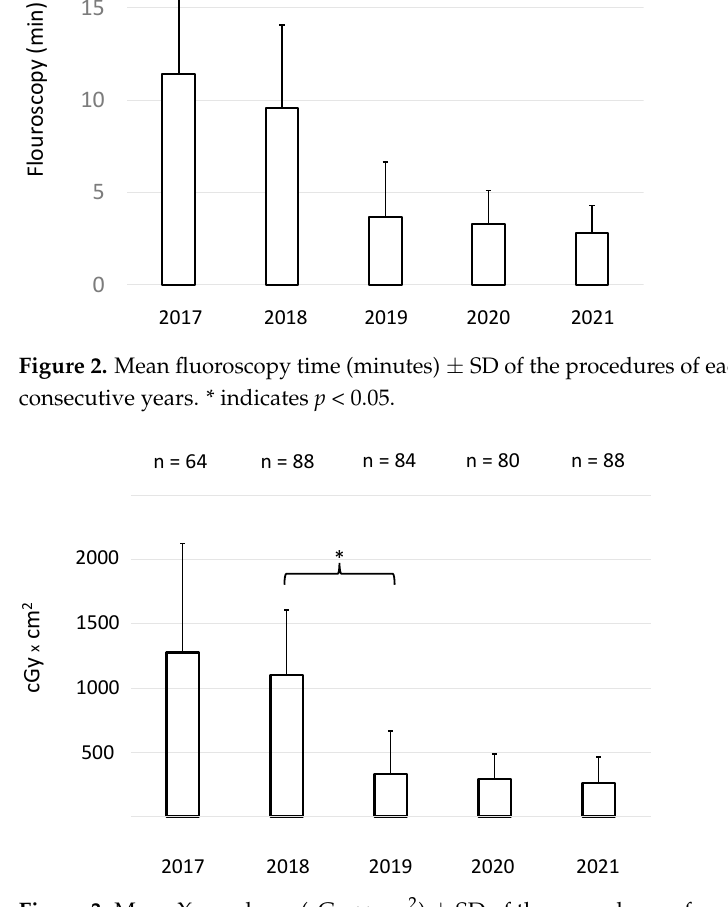
Figure 3. Mean X-ray doses (cGy × cm 2 ) ± SD of the procedures of each year over a period of five consecutive years. * indicates p < 0.05.